Question: Generate an informative caption for the figure above.
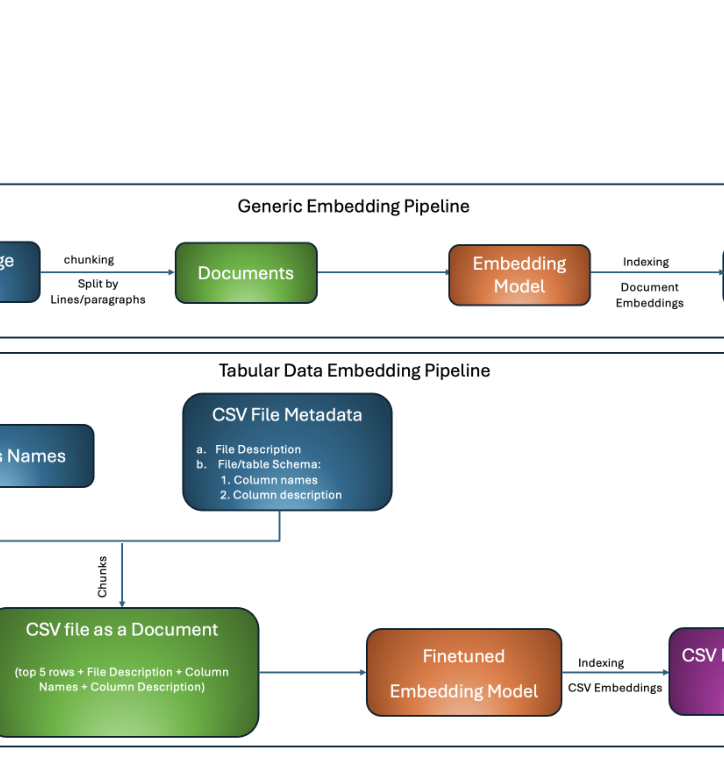
Answer: contrasts the tabular data indexing approach vs generic approach.